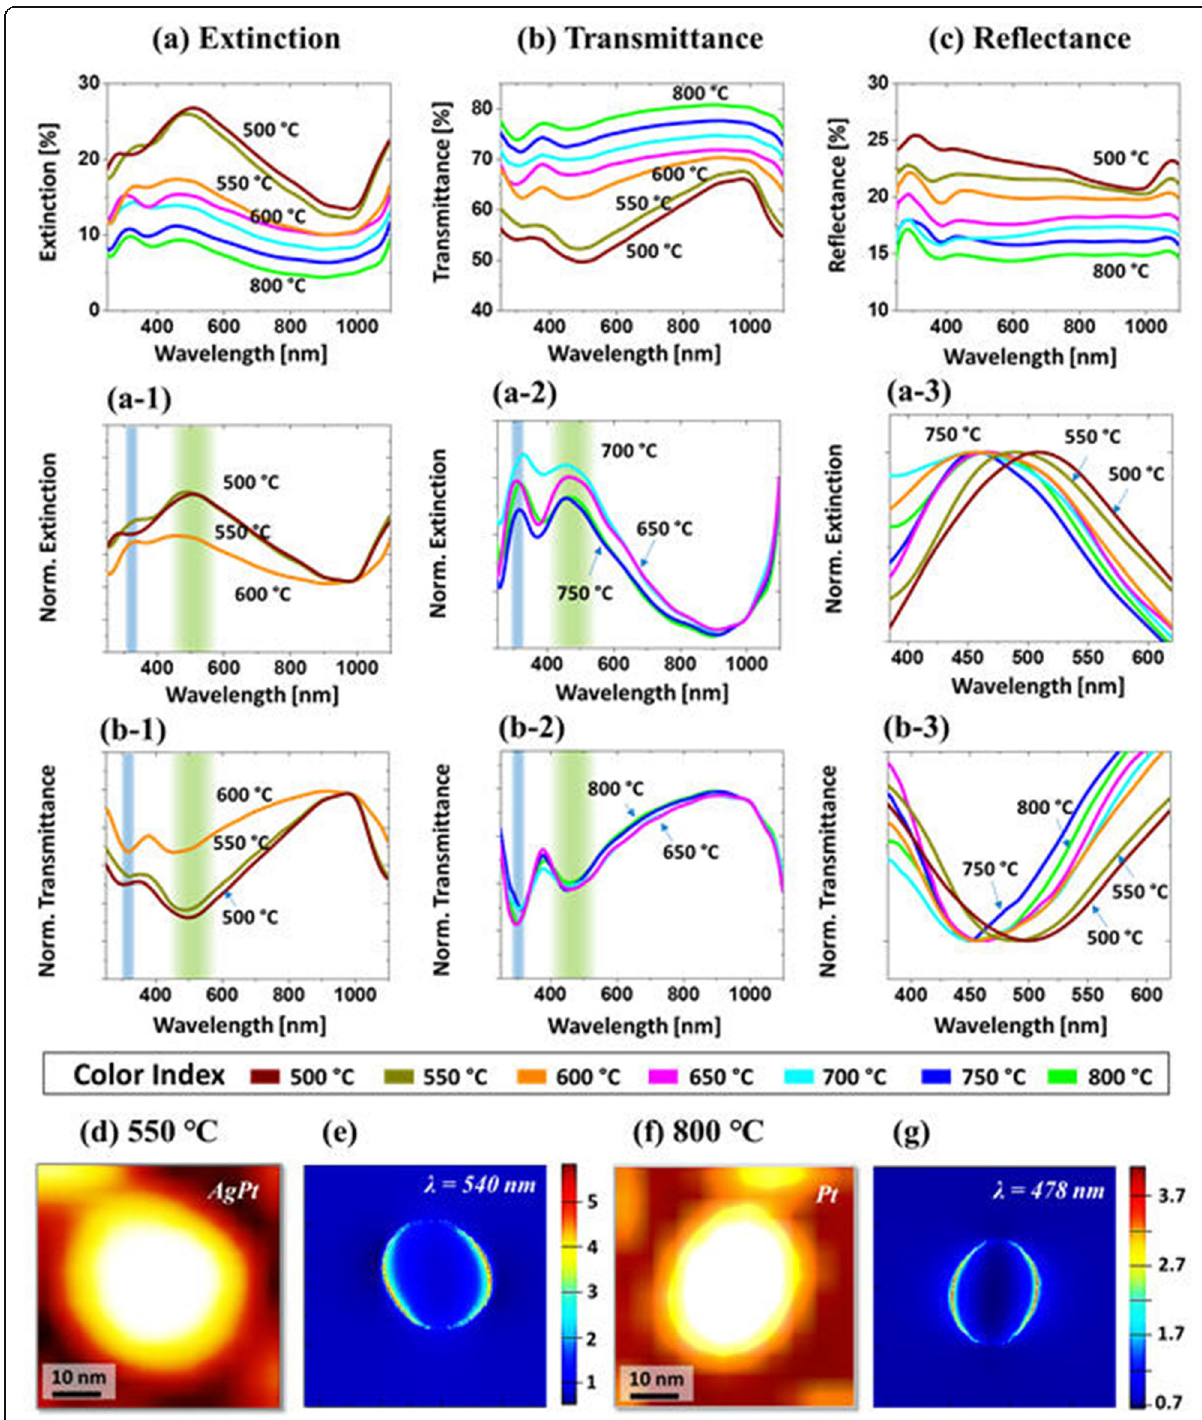
Fig. 4 LSPR properties of the AgPt and Pt NPs fabricated with the Ag5nm/Pt2.5nm bilayers by annealing between 500 and 800 °C. a – ( a-3 ) Extinction and normalized extinction spectra. b – ( b-3 ) Transmittance and normalized transmittance spectra. c Reflectance spectra. d, f AFM images of the typical AgPt and Pt NPs selected for FDTD simulation. e, f E-field distribution in xy